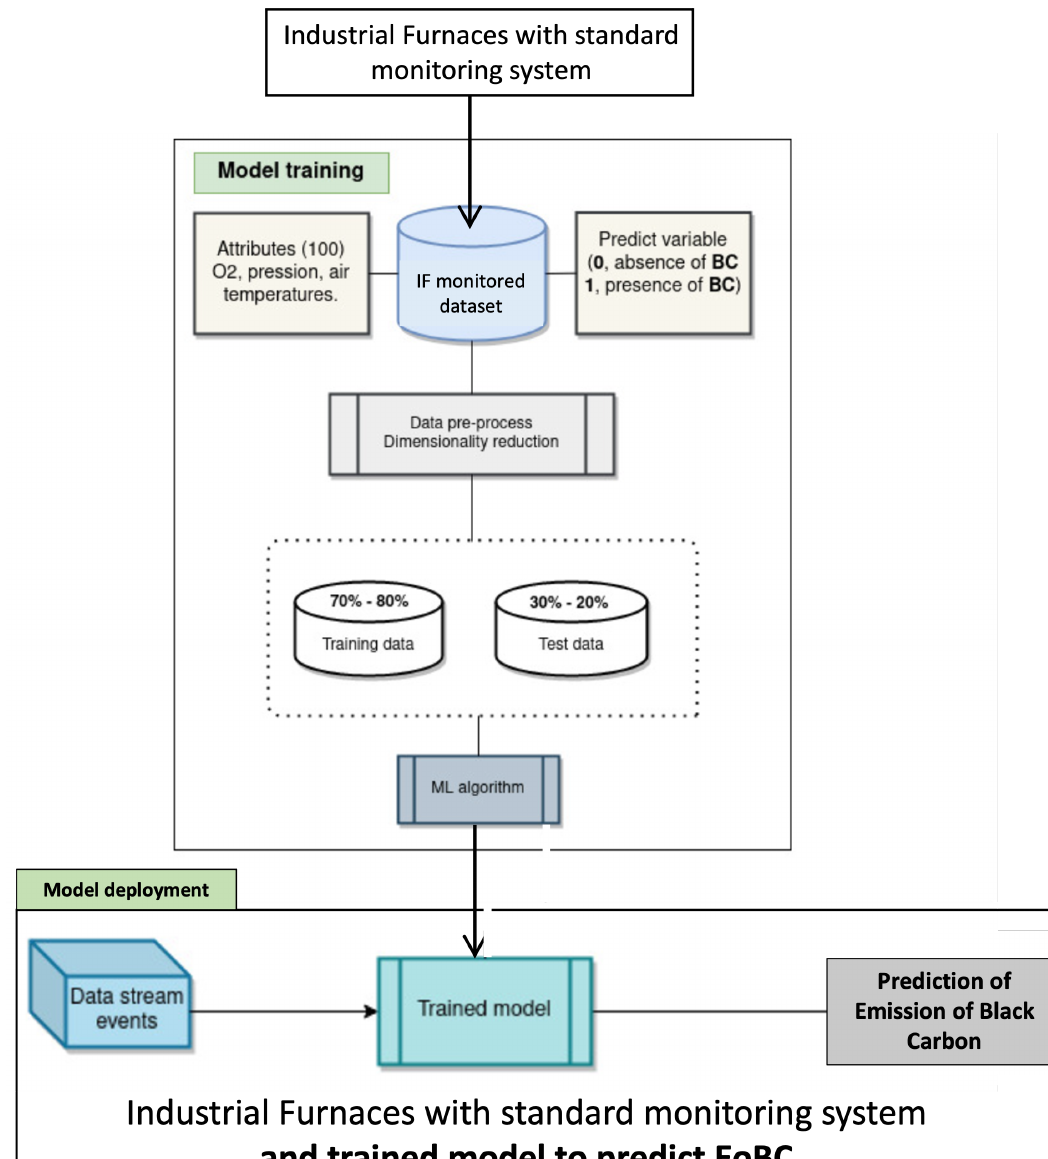
Figure 1. Proposed approach. Pipelines of the data